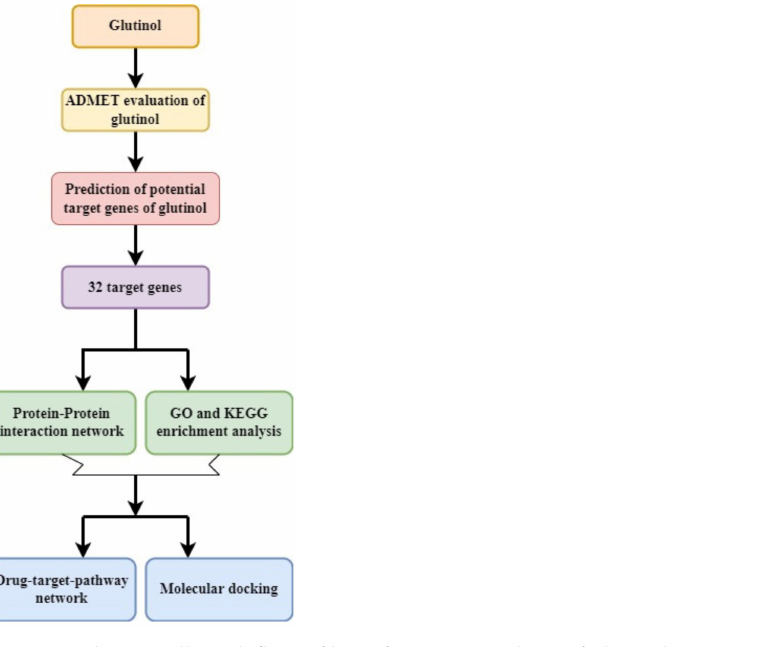
Figure 1. The overall work flow of bioinformatics analysis of